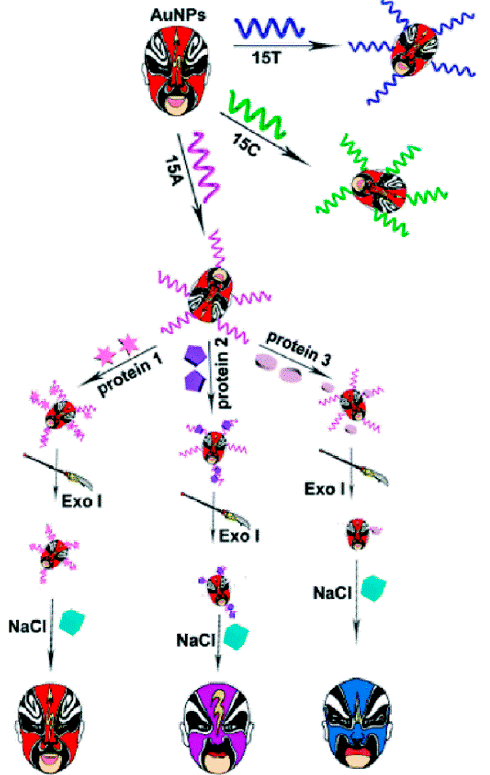
Figure 11. Schematic illustration of the design and fabrication process of the colorimetric sensor array for the identification of proteins. Reprinted with permission from Ref. [147]. Copyright 2019 RSC.